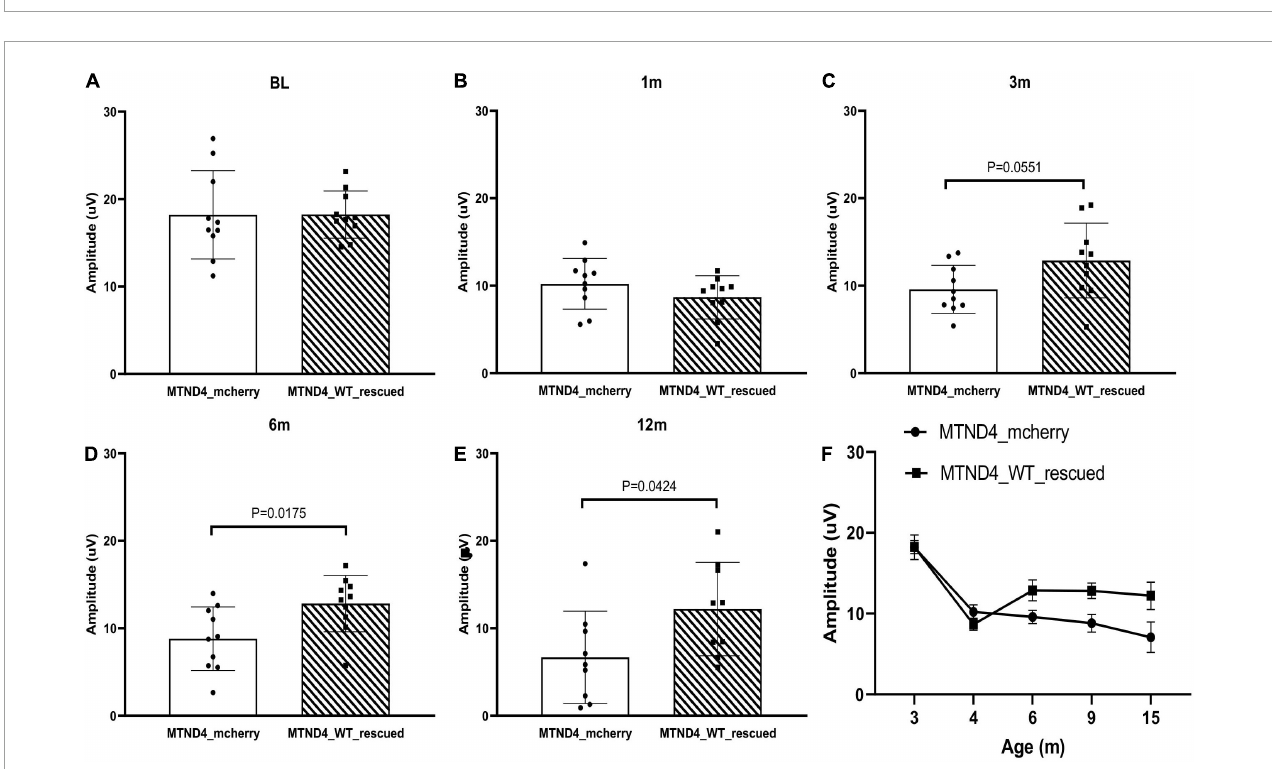
FIGURE2 Mito-targeted wtND4 rescue mutND4-induced RGC dysfunction. (A) Scatterplot of PERG amplitudes (average of both eyes) of all mice tested in each group showed no significant difference at the baseline (BL) between un-rescued (MTND4_mcherry) and rescued mice (MTND4_WT_rescued). (B) Mutant ND4 injection induced a significant decrease in PERG amplitude at 1 month after injection. Wildtype ND4 reverse the reduction PERG from 3 months (C) , 6 months (D) , to 12 months (E) after injection. (F) A line graph shows the mean PERG amplitude for un-rescued mice significantly decreased with age relative to rescued mice from 6 to 15 months after